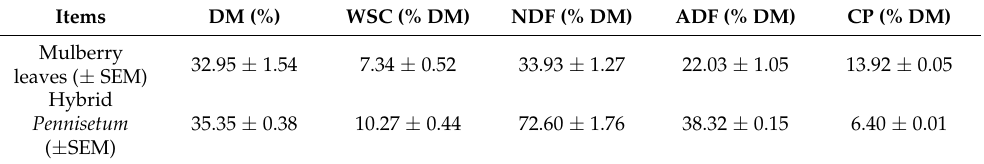
Table 1. The chemical composition of pre-ensiled mulberry leaves and hybrid Pennisetum